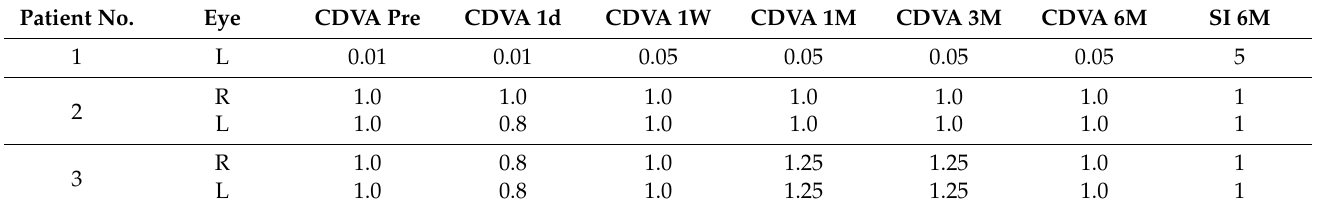
Table 1. Preoperative and postoperative CDVA up to six-month follow-up and safety indices of all patients.